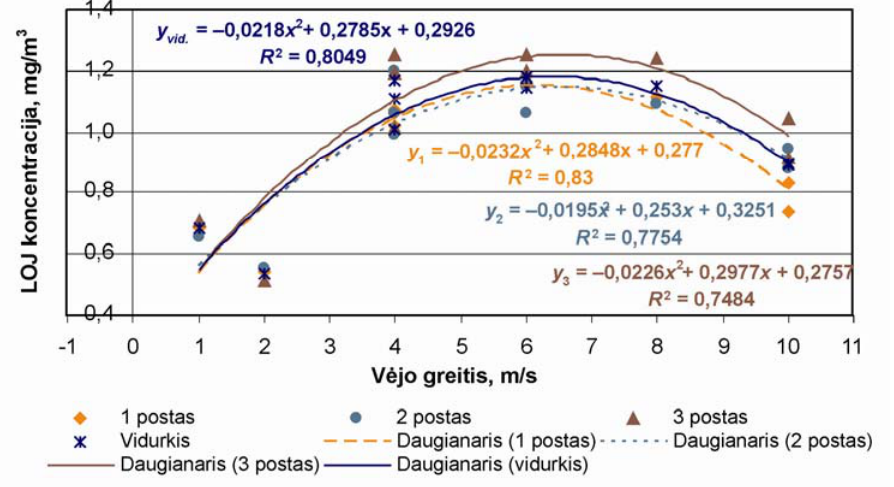
Fig 7. Dependence of VOC concentration in ambient air on wind speed (10-day